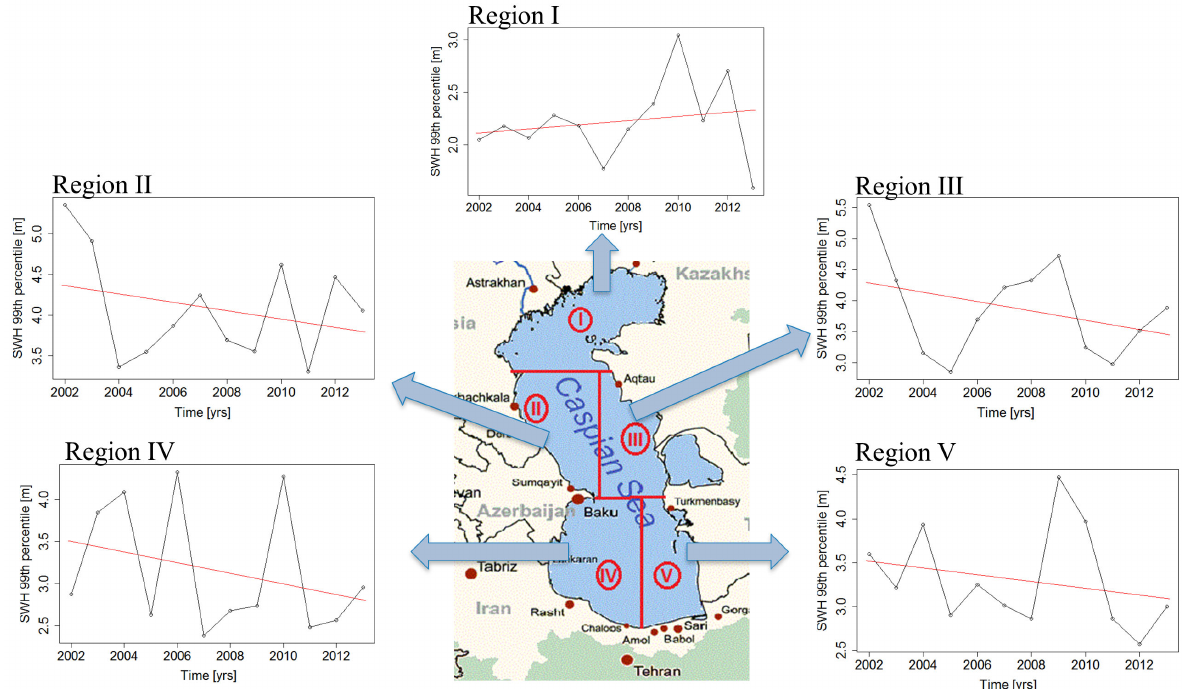
Fig. 10. Variations in the annual extreme wave heights (defined as the 99th percentile) of significant wave height (SWH) in five regions of the Caspian Sea. None of the linear trends (solid red lines) is statistically